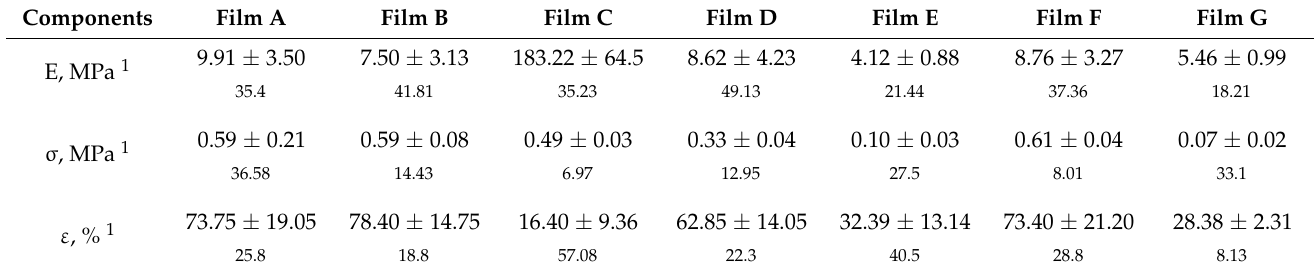
Table 3. Mechanical properties of the heat pressed films (E = Young’s Modulus, σ = Tensile strength and ε = Elongation at break).